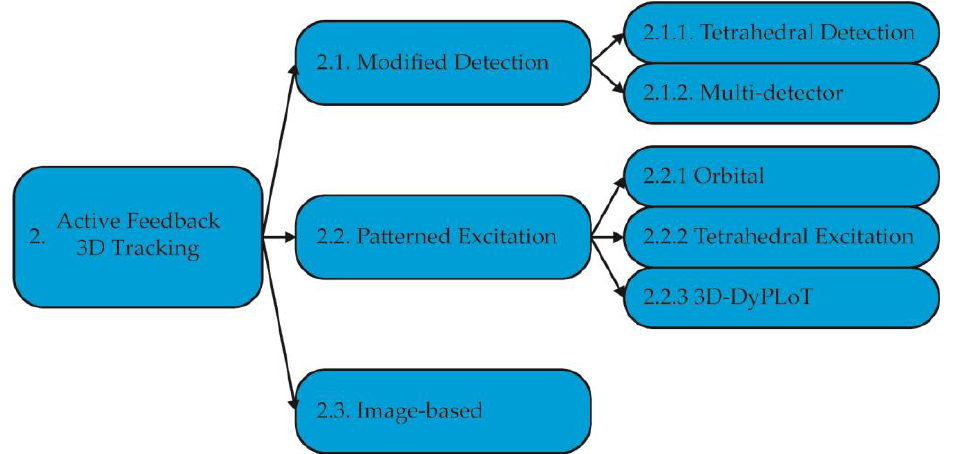
Figure 3. Overview of active feedback tracking methods covered in this review.